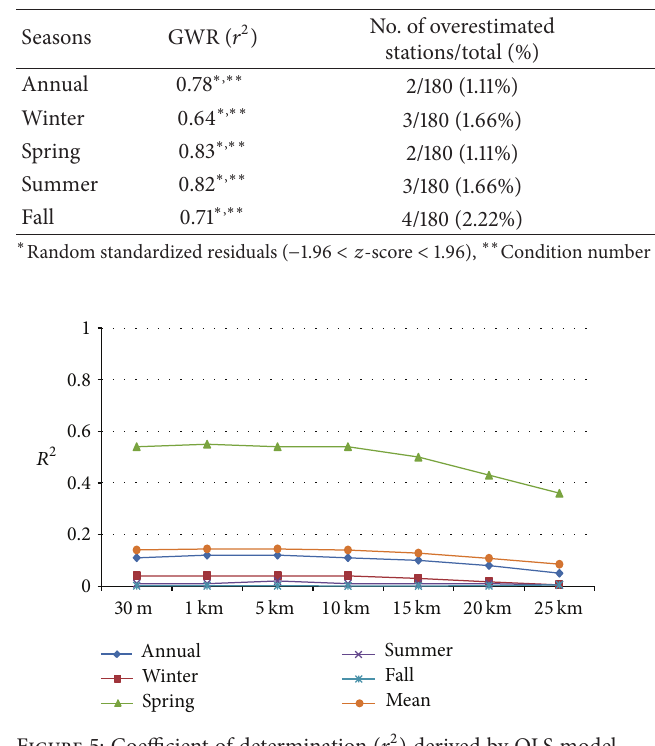
Figure 5: Coefficient of determination (𝑟 2 ) derived by OLS model against different smoothing window size of mean altitude values.